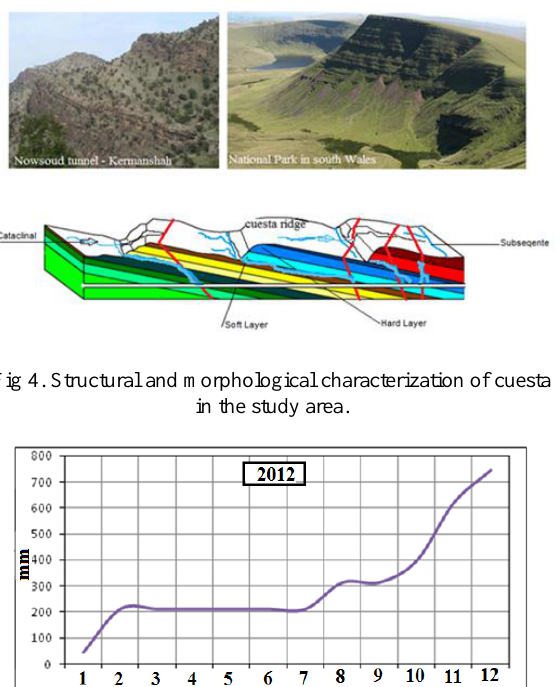
Fig. 2. A RGB color composite (bands 3, 2 and 1) of the ASTER image used.